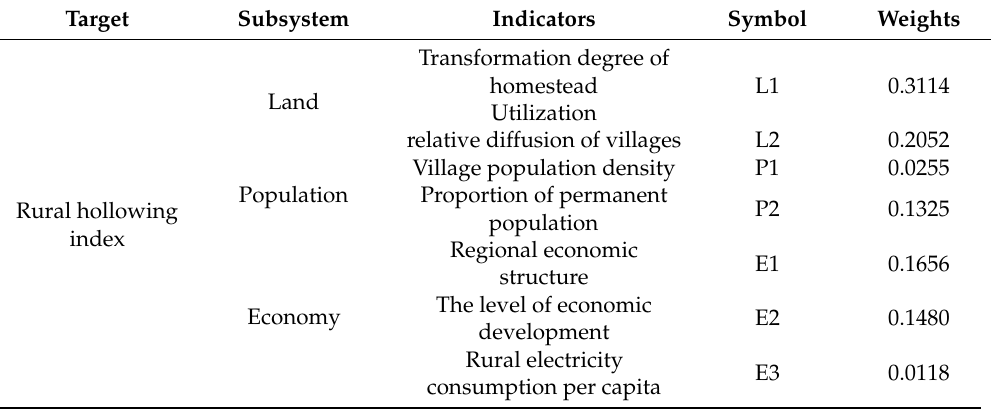
Table 3. The weight of the evaluation index of rural hollowing degree in Sichuan Province.